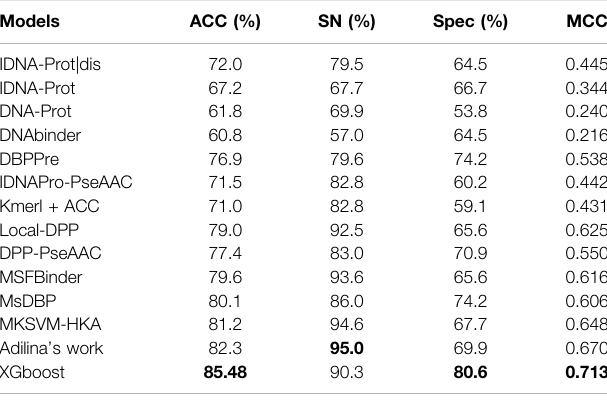
TABLE 4 | Comparison between the XGBoost model and other methods on the PDB186 data set. Models